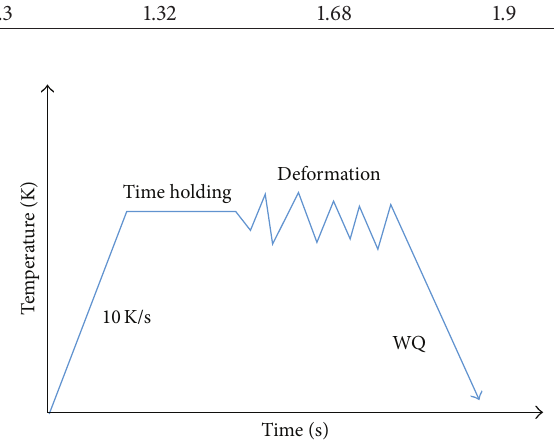
Figure 1: The general isothermal loading